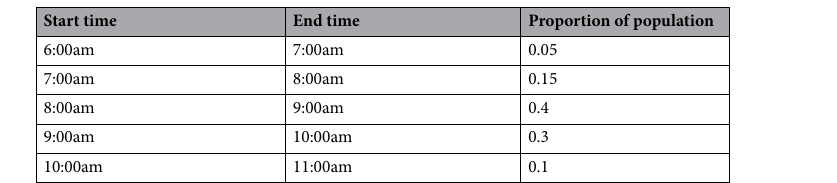
Table 1. Schedule used for controlling agent entrance to the floor over time. Each hour, the specified proportion of the population enters the floor from the designated entrances and heads to their respective office spaces. Agents spend 8 h within the simulation and then exit for the day, implicitly making the exit schedule symmetrically